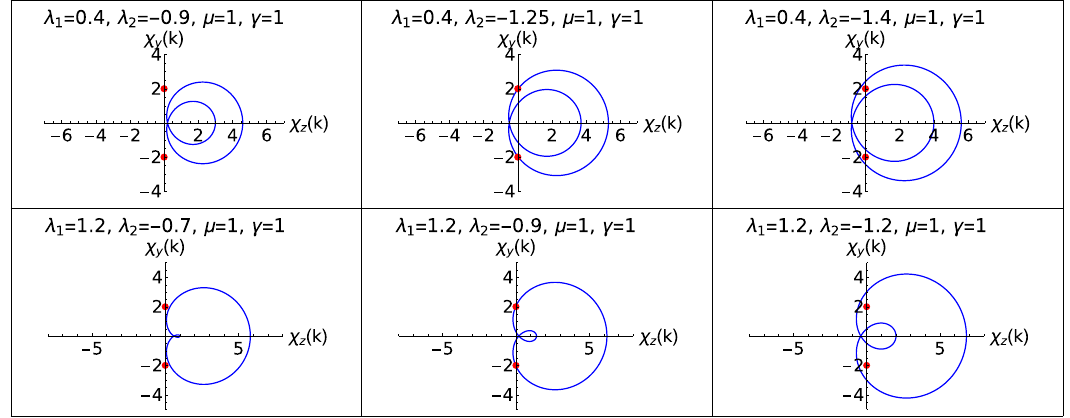
Figure 5. Parametric plots representing the topological phase transitions in the negative (cid:31) 2 region. Upper and lower panel corresponds to W=0–1 for different values of (cid:31) 1 respectively. Middle plot in both the panels represents the parametric curves at critical points.